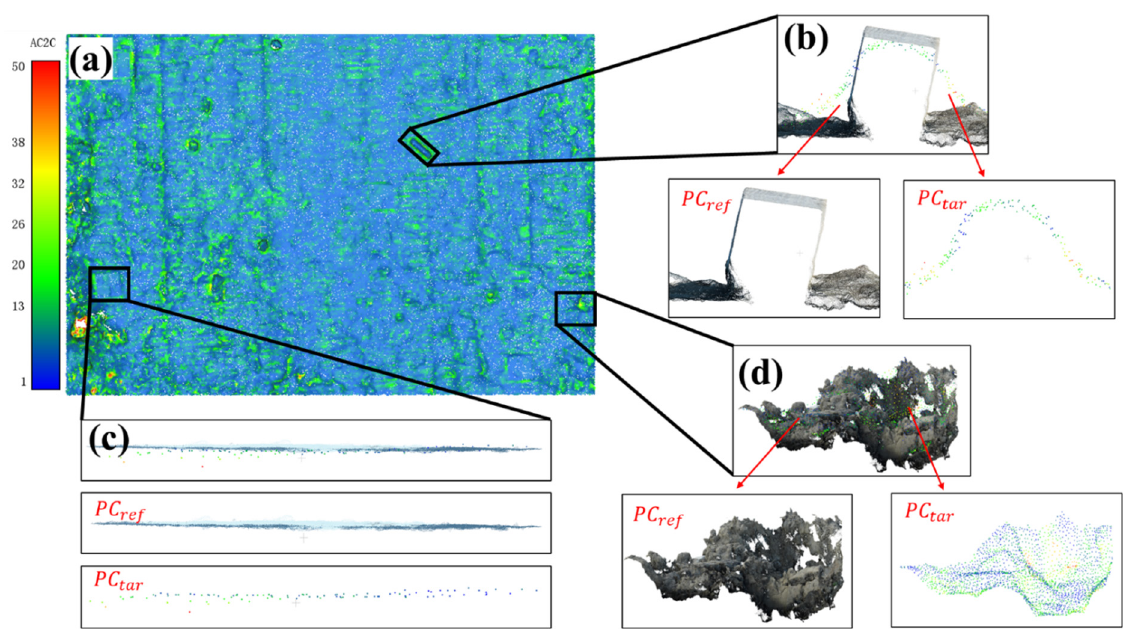
Figure 11. AC2C distance calculation results and details in NWC. ( a ) overview, ( b ) wood block , ( c ) control point, and ( d ) potholes on the surface .